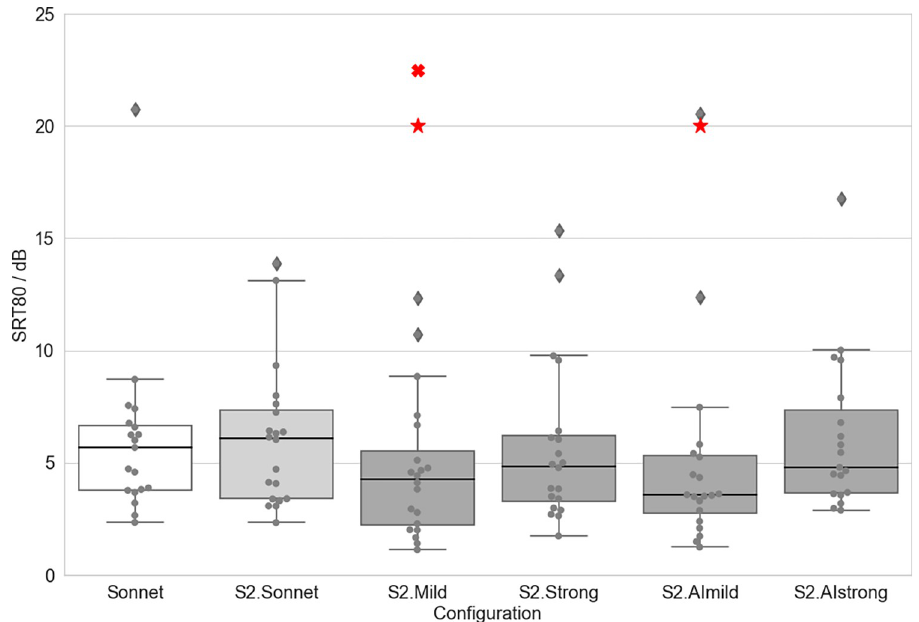
Fig 3. SRT80 observed in the OLSA S0N0 for each configuration. A cross marks a significant difference compared to S2.Sonnet. A star marks a significant difference compared to the SONNET. Boxplots show median values as well as first and third quartiles. Whisker bars show minimum and maximum values within 1.5 interquartile ranges below and above the first and third quartile. Diamonds show outliers.